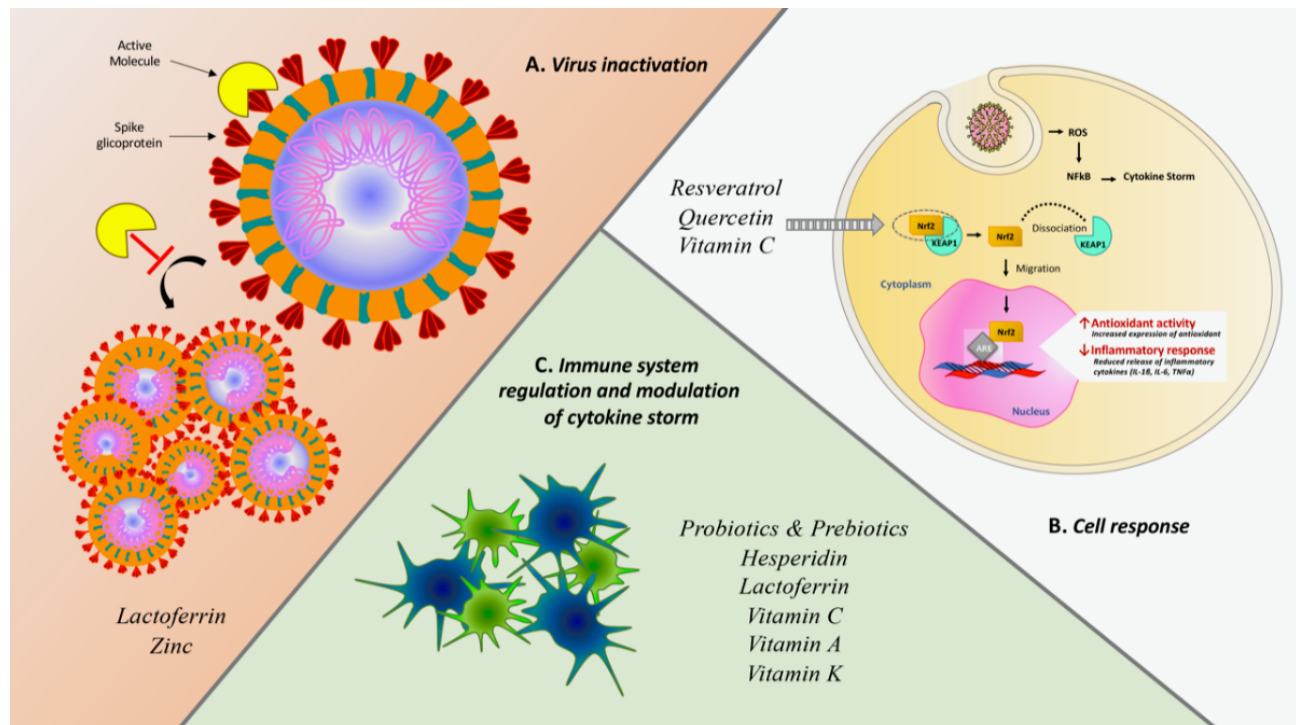
Figure 2. Summary scheme of several mechanisms exploited by nutraceuticals against SARS-CoV-2 infection. ( A ) Antiviral effect due to the direct interaction with SARS-CoV-2 spike protein or inhibitory effect of viral proliferation. ( B ) Cell response induced by the activation of Nrf2 and following genetic regulation downstream. Activated Nrf2 dissociates from its complex with KEAP1 and migrates from cytoplasm to nucleus within which it interacts with ARE (Antioxidant Response Element) sequences producing gene regulation both promoting antioxidant response and reducing the inflammatory cascade (49). ( C ) Indirect immune system modulation through enhancement of immune performance and concurrent decrease of pro-phlogistic cytokines like IL-6 IL-1β and TNFα in order to mitigate the harmful effects of cytokine storm.